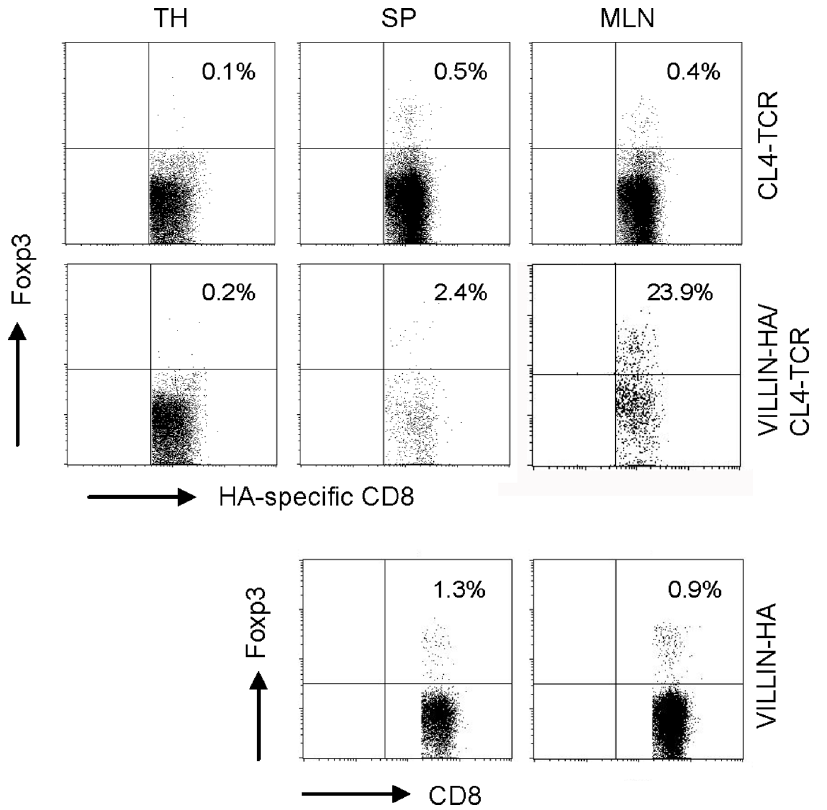
Figure 1. Induction of antigen-specificCD8 + Foxp3 + Tcells invivo. Lymphocytes from the thymus (TH), spleen(SP) and mesentericlymphnodes (MLN) of CL4-TCR, VILLIN-HA/CL4-TCR and VILLIN-HA transgenic mice were stained for the expression of CD8 and H-2K d IYSTVASSL and analyzed regarding the expressionofFoxp3.PercentageofFoxp3 + Tcellsisindicated.Onerepresentativeexperimentoutoffourindependentexperimentswithsimilarresultsisshown.